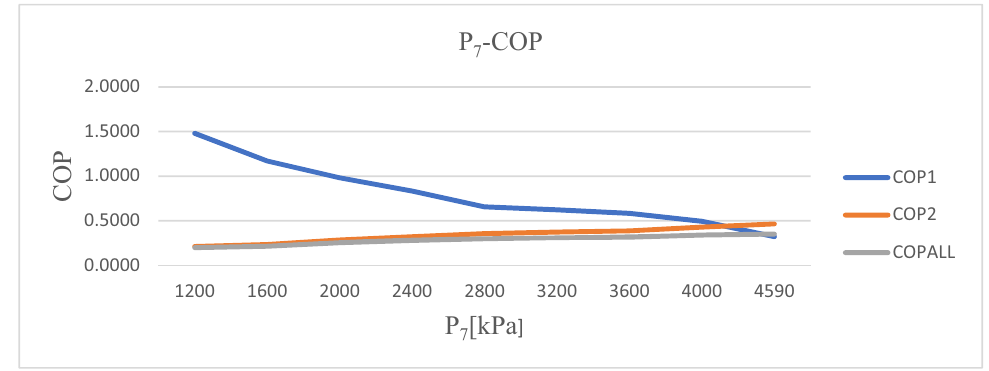
Figure 4: COP 1 , COP 2 , and COP all curves of the whole cycle obtained for di ff erent outlet pressures at which the fi rst - stage compressor of the vapor compression two - stage cascade cryogenic cycle can operate.